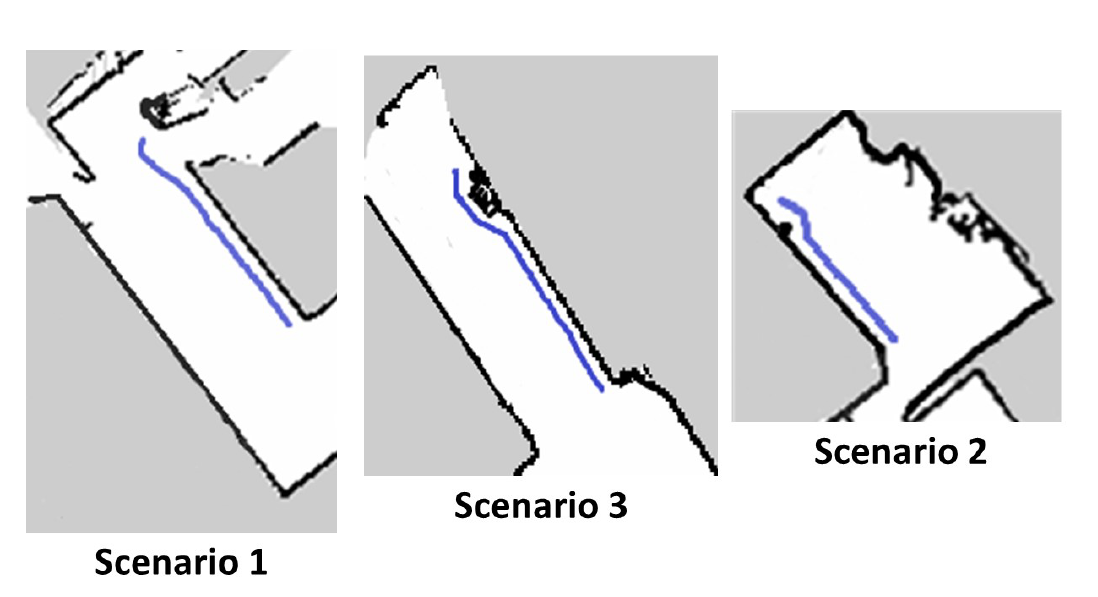
Figure 19. Generated path of HSR robot after completing the wall following task in scenario 1 ( top left ), scenario 2 ( top right ), scenario 3 ( bottom ).